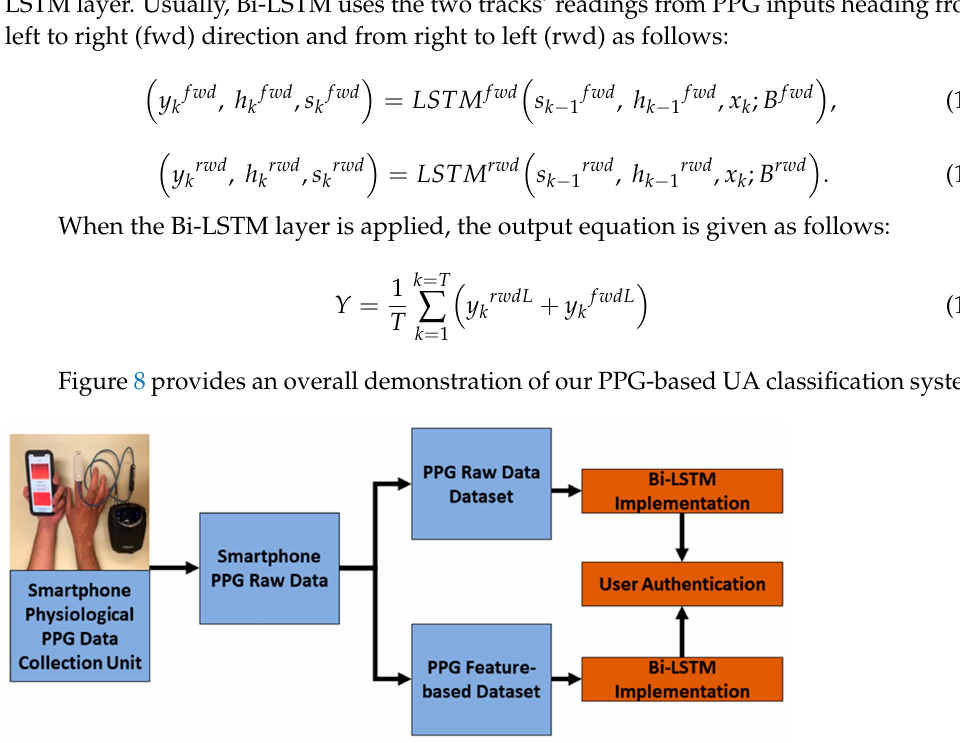
Figure 8. Proposed UA-system diagram with two alternative deep learning classification systems.